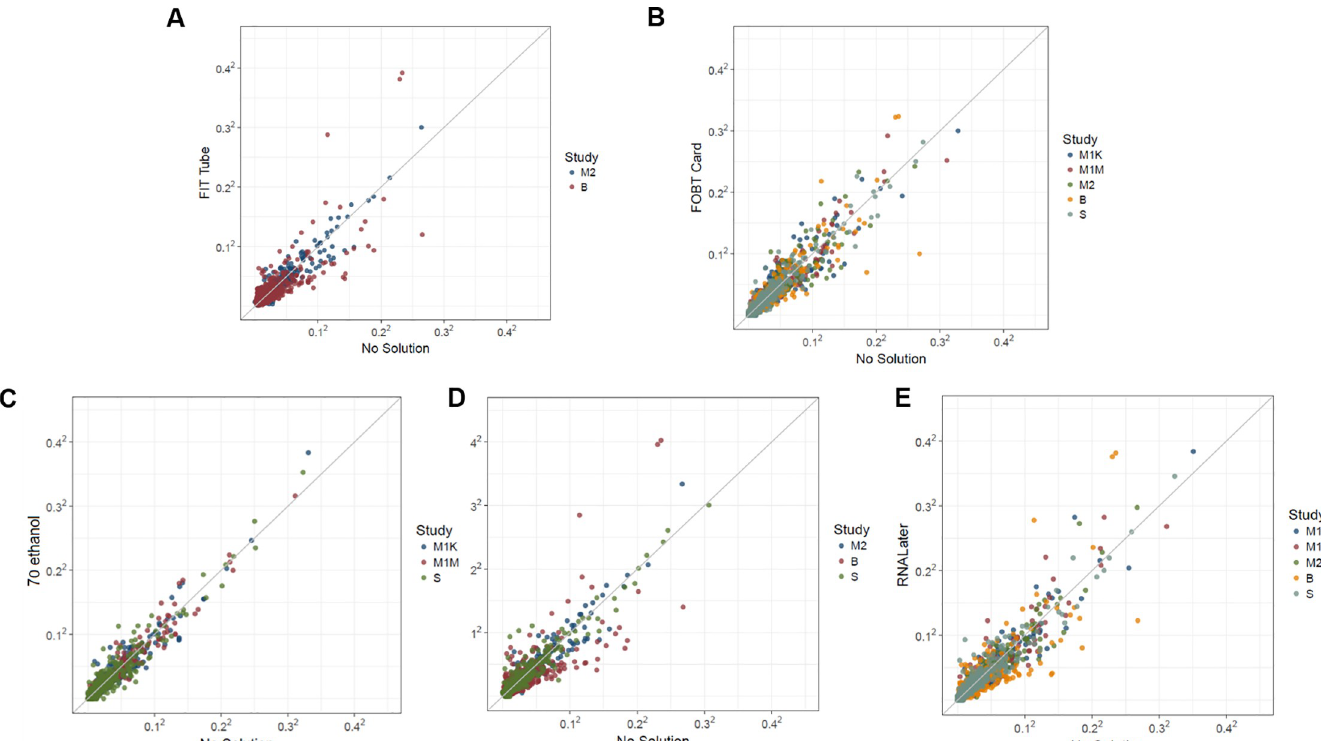
Fig 4. Comparison of mean OTU abundance for each fecal sample collection method frozen on day-0 compared to no-solution samples frozen on day-0 (the gold standard) for fecal samples from 132 participants in five studies (Mayo 1-Knight lab, Mayo 1-Mayo lab, Mayo 2, Bangladesh, and Colorado), collected using five different methods (A) FIT tubes, (B) FOBT cards, (C) 70% ethanol, (D) 95% ethanol, and (E) RNA later . Abbreviations : B , Bangladesh; FIT , fecal immunochemical tests; FOBT , fecal occult blood test cards; FTA , Flinders Technology Associates cards; M1K , Mayo 1 Knight Laboratory; M1M , Mayo 1 , Mayo Laboratory; M2 , Mayo 2; OTU , operational taxonomic unit; S , Colorado Study .